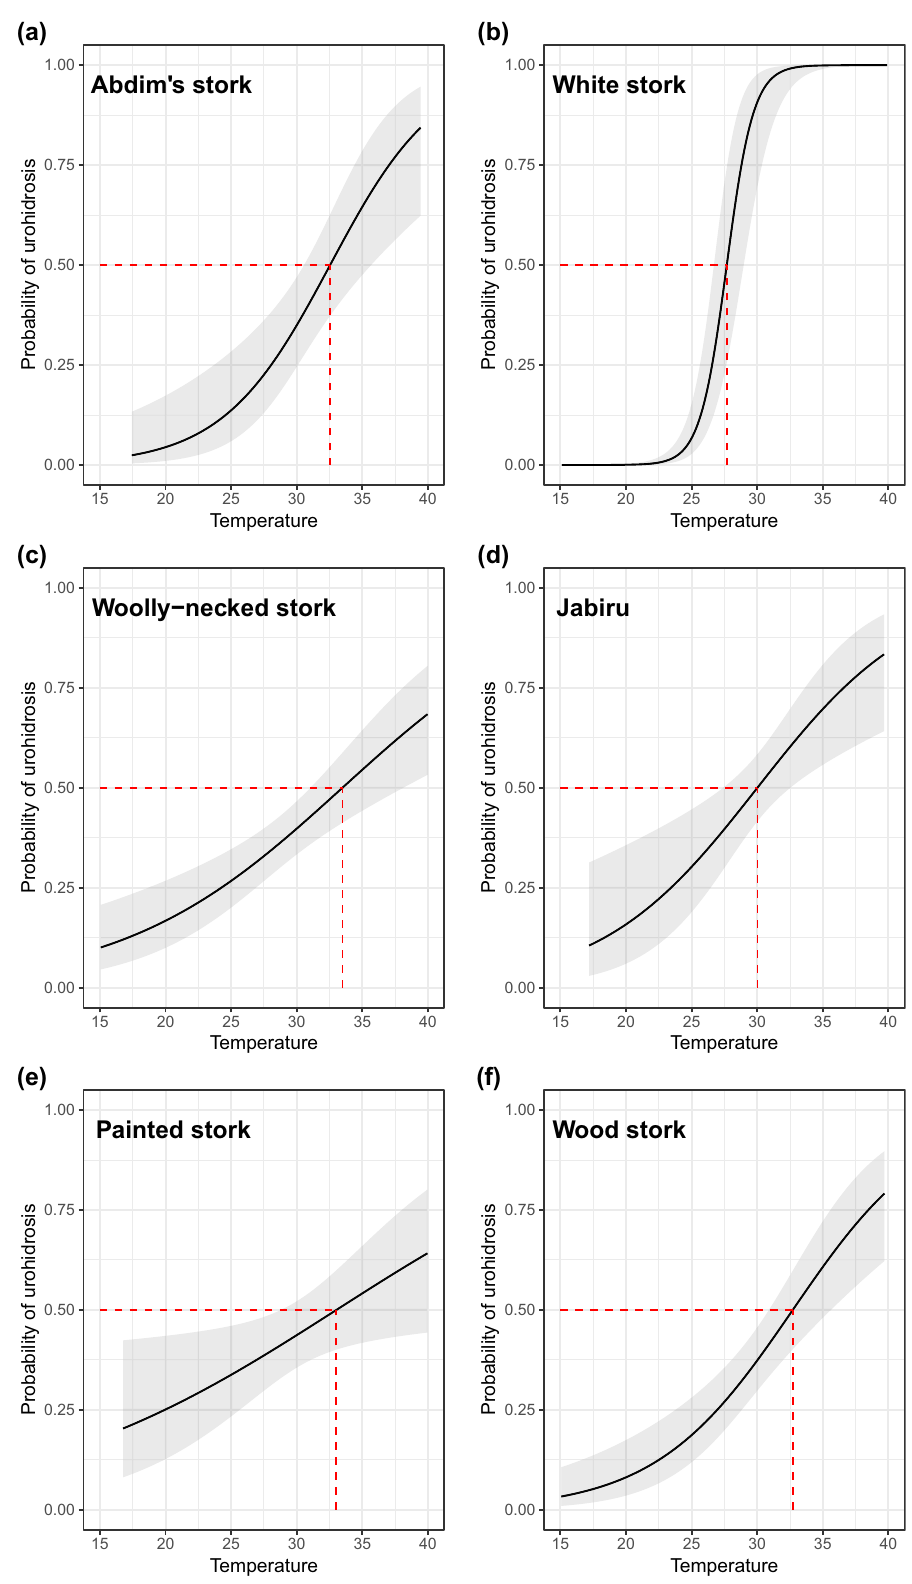
Figure 3. Probability of urohidrosis use in response to air temperature for ( a ) Abdim’s stork Ciconia abdimii, ( b ) white stork Ciconia ciconia , ( c ) woolly-necked stork Ciconia episcopus , ( d ) jabiru Jabiru mycteria , ( e ) painted stork Mycteria leucocephala and ( f ) wood stork Mycteria americana . Dashed red lines indicate the air temperature at which urohidrosis occurred in 50% of